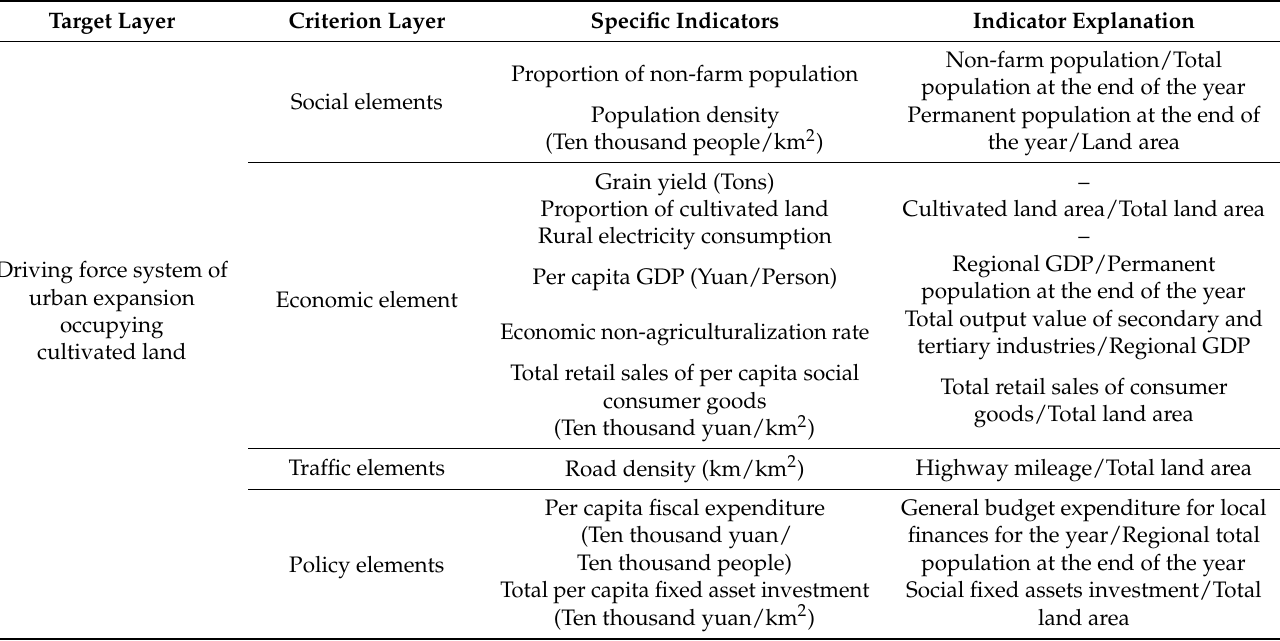
Table 1. The driving force system of cultivated land occupied by urban expansion.